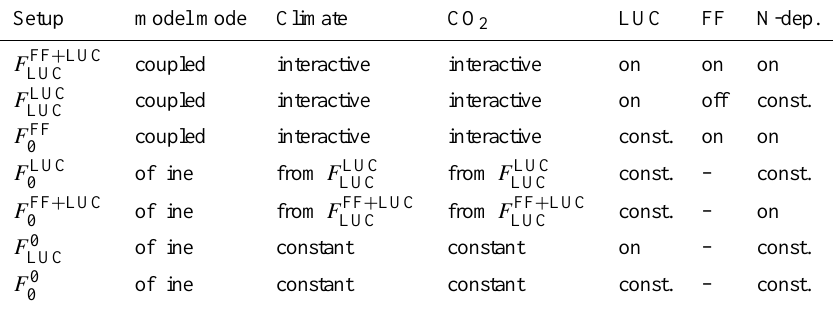
Table 1. Model setups. F is the simulated total net flux of C from the terrestrial biosphere to the atmosphere. Subscript 0 refers to a setup where the area under use is kept constant at 1700 conditions and subscript LUC to a setup where the area under use is transiently varying following the land cover data by Hurtt et al. (2006). Superscript LUC and FF refer to environmental changes (CO 2 , climate, etc.) due to LUC forcing and non-LUC related forcing (FF) or their combination (FF + LUC). Simulations with superscript “0” are forced by constant environmental (climate and CO 2 ) conditions (e.g. preindustrial or modern). In coupled simulations, climate and CO 2 evolve interactively as simulated by the coupled Bern3D-LPX model. The offline model mode uses either outputs from the coupled simulations or constant climate and CO 2 and F is computed with the stand-alone vegetation model LPX. N-deposition (“N-dep.”) is prescribed from Lamarque et al. (2011). Setup model mode Climate CO 2 LUC FF N-dep. F FF + LUC coupled interactive interactive on on on LUC F LUC coupled interactive interactive on off const. LUC F FF coupled interactive interactive const. on on 0 F LUC offline from F LUC from F LUC const. – const. 0 LUC LUC F FF + LUC offline from F FF + LUC from F FF + LUC const. – on 0 LUC LUC F 0 offline constant constant on – const. LUC F 0 offline constant constant const. 0